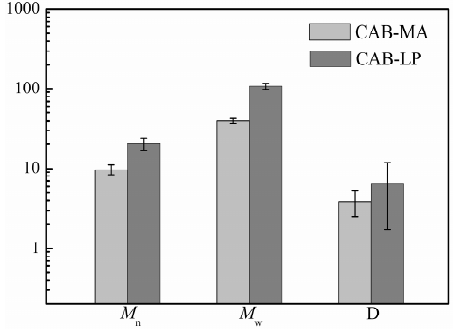
Figure 3. Relative molecular weight and molecular weight distribution of CAB-MA and CAB-LP ( n = 3).